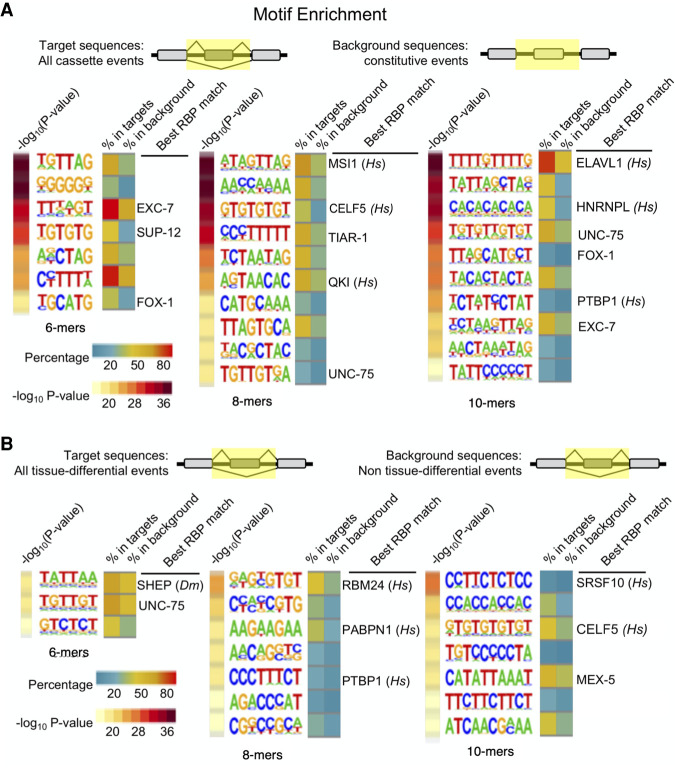
Enriched cis elements surrounding alternative exons and tissue-regulated alternative exons. (A) Enriched motifs identified when comparing all cassette-type alternative exons with constitutive exons. Top panel displays the regions compared (highlighted in yellow) spanning internal exon and flanking introns. Enrichment P-values are listed to the left of the motifs as −log10-transformed values (yellow–red scale). Motifs are presented as sequence logos derived from cis elements observed in the data. The percentage of sequences in the target group versus the background group are displayed to the right of the motif logos (blue–yellow–red scale). If a sequence motif overlaps with a known consensus motif for an RBP identified, the RBP is labeled as well as the species the consensus was derived from. (Hs) Homo sapiens. (B) Same as in A, except target sequences are tissue-regulated alternative splicing events and background sequences are non-tissue-regulated alternative splicing events. (Hs) Homo sapiens, (Dm) D. melanogaster.